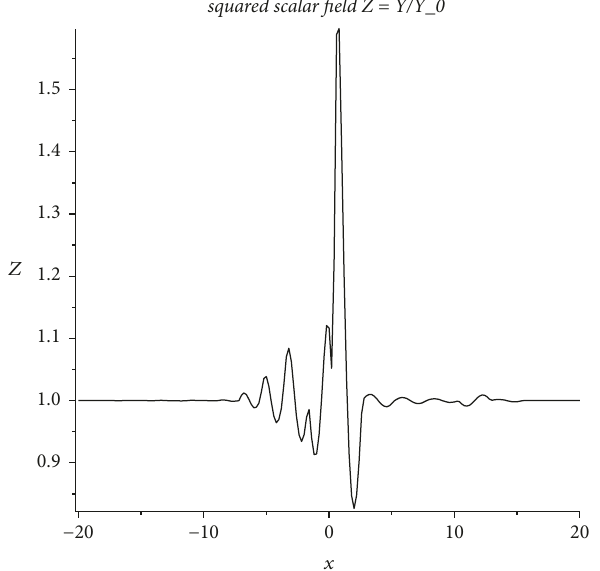
Figure 6: Relation of 𝑍 = 𝑍(𝑥) , where 𝑍(1) = 𝑍 𝑚 = 1.40908675530186 : 𝑥 = 𝑡/𝑡 1.44517022939 , 𝑘